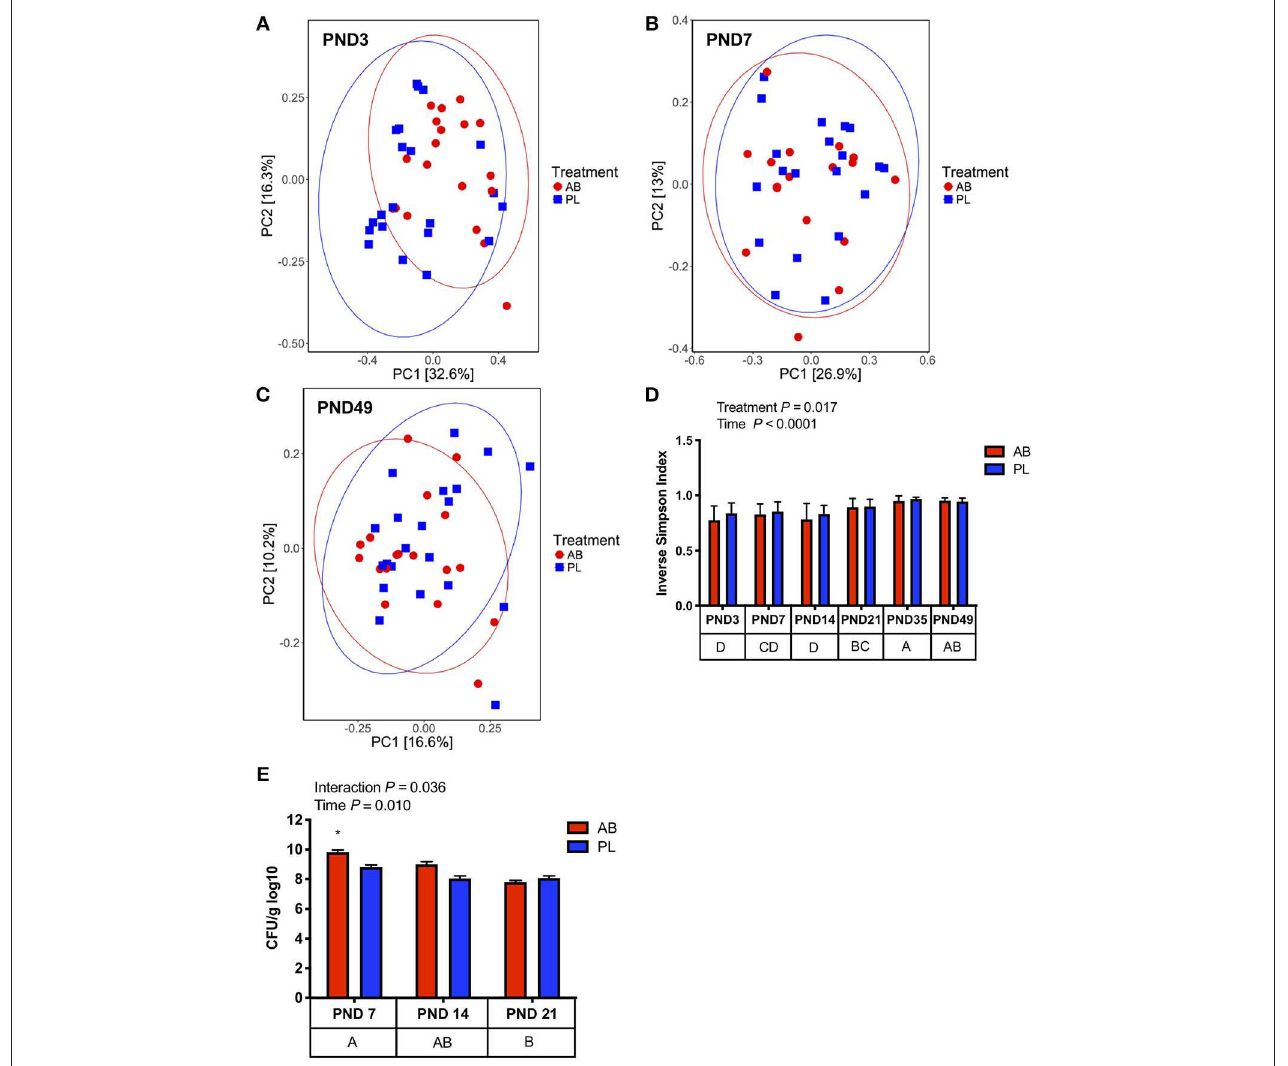
FIGURE 2 | Pigs treated with antibiotics (AB) from day 0–14 had transient changes in microbial community composition compared to those treated with placebo (PL), as determined with Bray-Curtis dissimilarity. (A) On PND 3 there is distinct clustering of pigs treated with AB vs. PL (Adonis, P = 0.025); AB n = 20, PL n = 21; (B) On PND 7 no distinct clustering was observed between pigs treated with AB and PL (Adonis, P = 0.693); AB n = 17, PL n = 20. (C) On PND 49 pigs treated with AB and PL were not distinctly clustered (Adonis, P = 1.0) (D) Alpha diversity was reduced in AB treated pigs and significantly increased overtime (Two-way ANOVA,